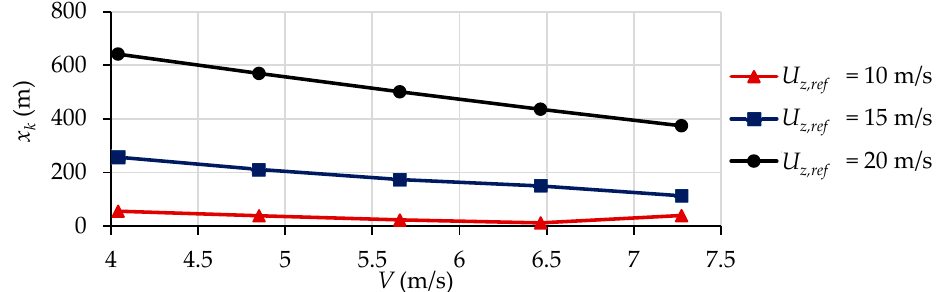
Figure 13. The optimal kite elevations for different ship and wind speeds and a kite area of 320 m 2 .